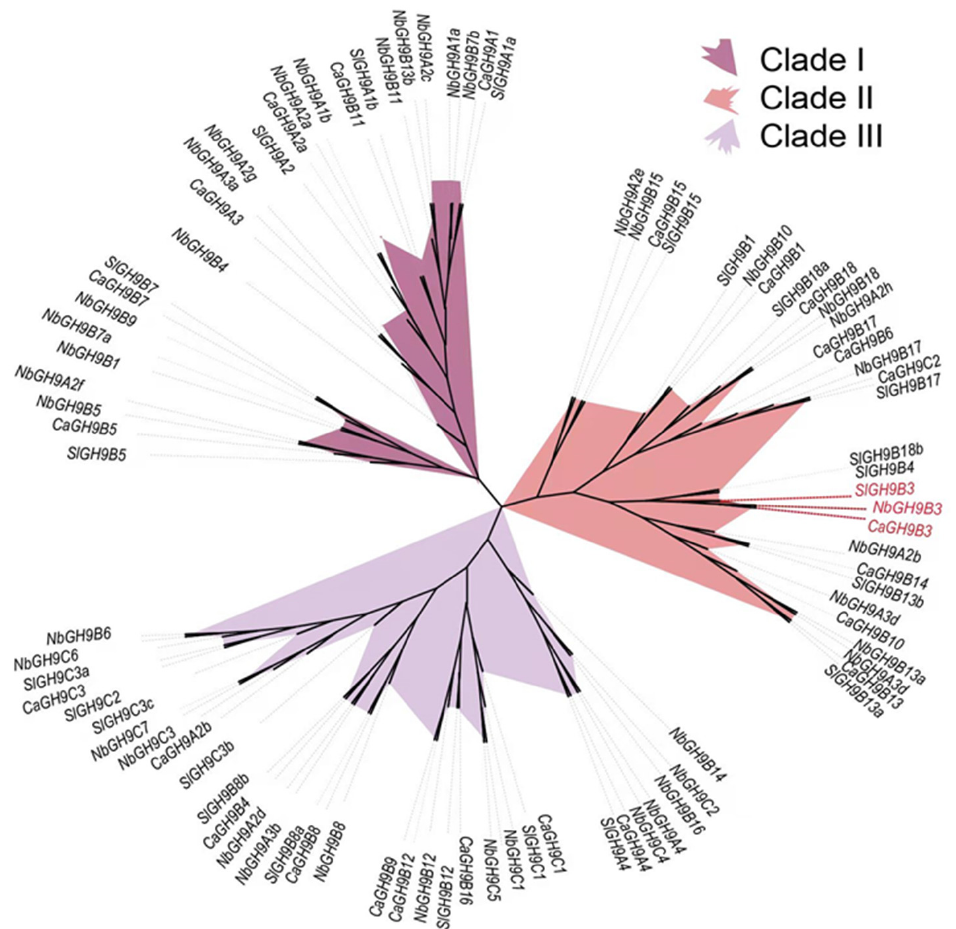
Figure 1. Phylogenetic tree of GH9 family members from pepper ( Capsicum annum ), tomato ( Solanum lycopersicum ) and tobacco ( Nicotiana benthamiana ). MEGA7 was used to construct the maximum ‐ likelihood tree, and the tree was visualized using iTOL web server. Different colors represent different clades, and the red branches are GH9B3.